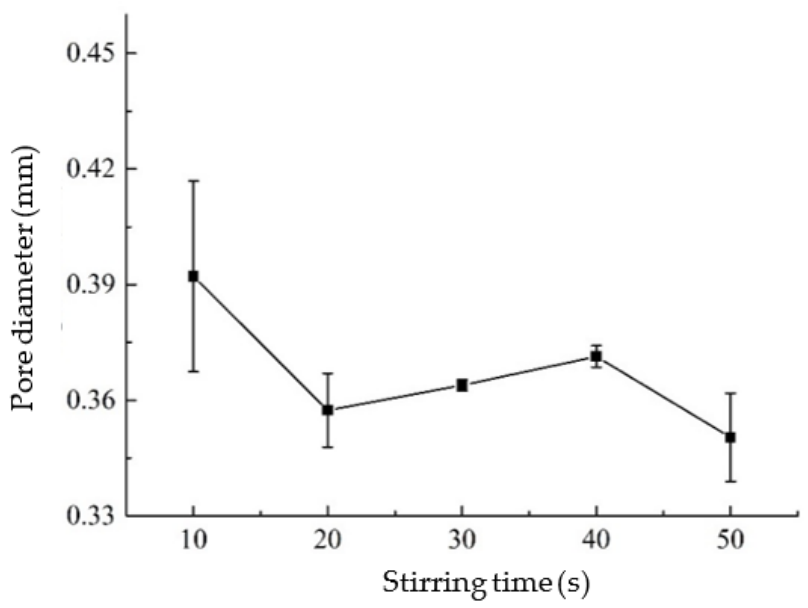
Figure 8. Influence of stirring time on pore diameter.